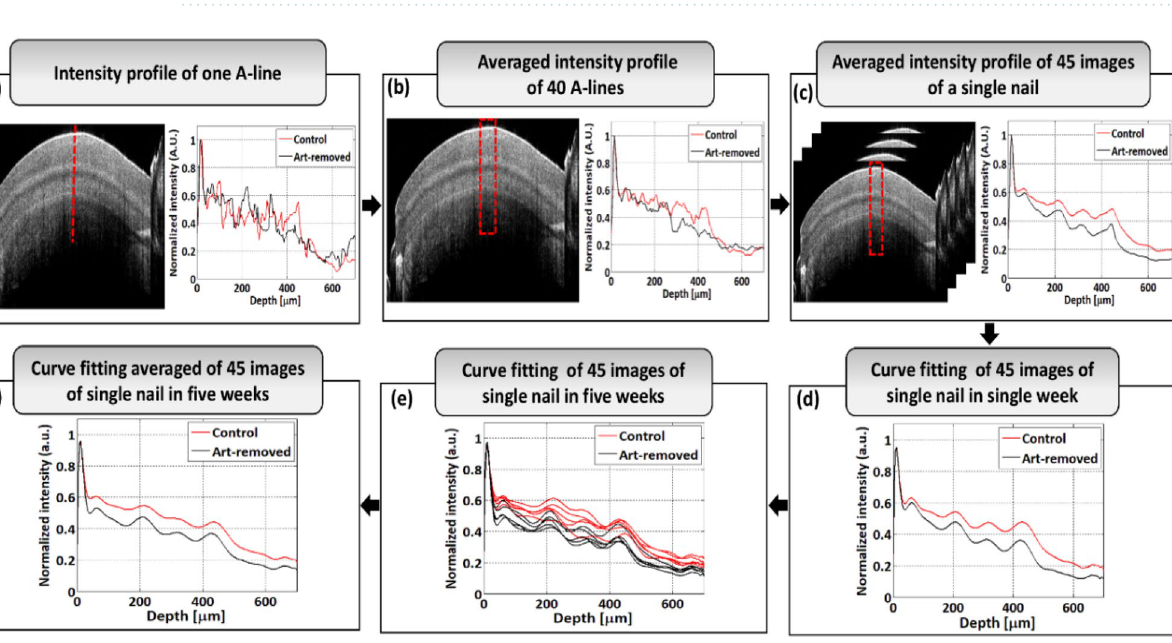
Figure 3. Algorithm of measuring the back-scattered intensity and nail plate thickness. ( a ) Intensity profile of one A-line. ( b ) Averaged intensity profile of 40 A-lines. ( c ) Averaged intensity profile of 45 images of a single nail with 40 A-lines of each image. ( d ) Curve fitting of 45 images of the single nail in a single week. ( e ) Curve fitting of 45 images of a single nail in five weeks. ( f ) Curve fitting averaged of 45 images of a single nail in five